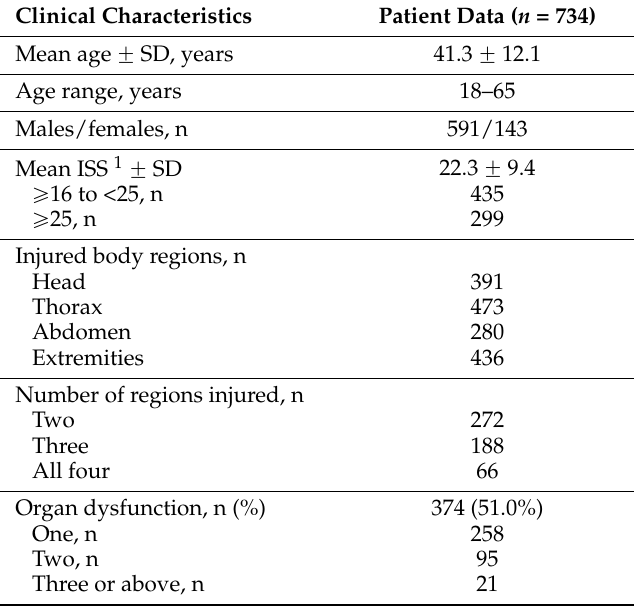
Table 3. Overall clinical characteristics of trauma